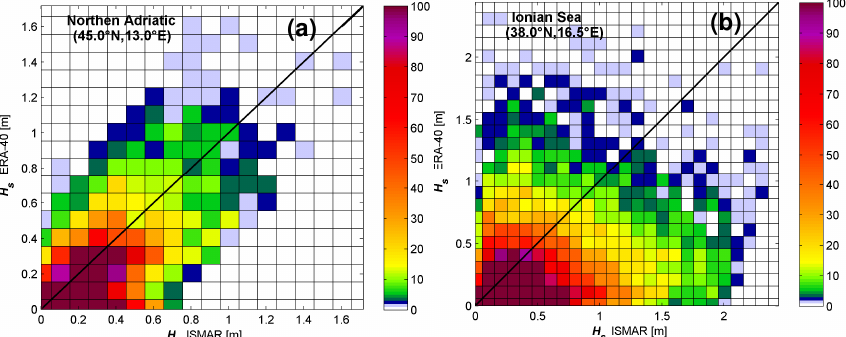
Fig. 2. Scatter diagram of calibrated ERA-40 UNILE significant wave height vs. ISMAR significant wave height. Scatter diagrams have cluster size of 0.1 by 0.1m. Colorbar units are counts per cluster. The overlapped time interval between the ERA-40 UNILE and the ISMAR timeseries goes from 1 July 1992 to 31 December 1999.